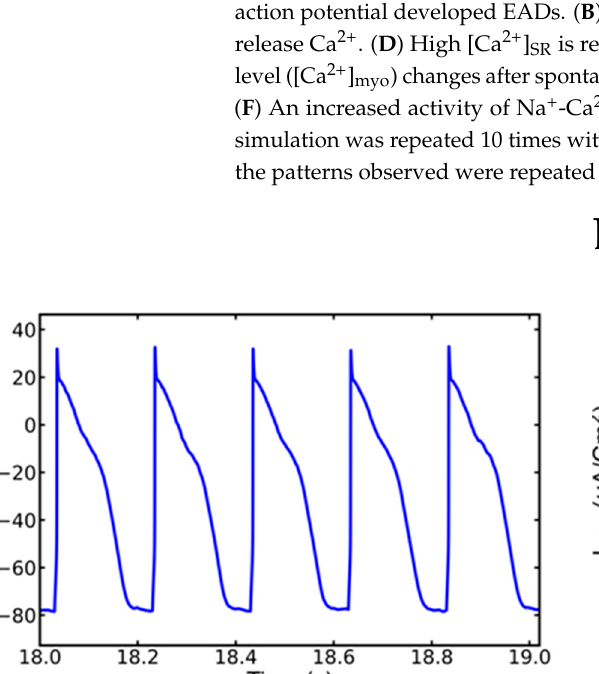
Figure 6. A comparison of AP, channel gating, Ca 2+ transients, and ionic currents during β -adrener- gic receptors activated myocytes show spontaneous Ca 2+ release develops EADs in the second slow pacing after myocyte went through rapid pacing. The plots represent the combined simulations of 7.5 s to 9.5 (blue) s and 21.5 s to 23.5 s (red). ( A ) A normal action potential in the slow pacing ahead of the rapid pacing (blue), but it changed in the subsequent slow phase right after the rapid pacing where action potential developed EADs. ( B ) L-type channel current. ( C ) The RyR2 channels spon- taneously release Ca 2+ . ( D ) High [Ca 2+ ] SR is responsible for spontaneous Ca 2+ release. ( E ) Cytoplasmic Ca 2+ level ([Ca 2+ ] myo ) changes after spontaneous Ca 2+ release and late reactivation of L-type Ca 2+ chan- nels. ( F ) An increased activity of Na + -Ca 2+ exchange current (I ncx ) is supportive of elongate APD. The simulation was repeated 10 times with different seeds for the pseudo random number generator and the patterns observed were repeated each time. Shown here is a representative simulation.